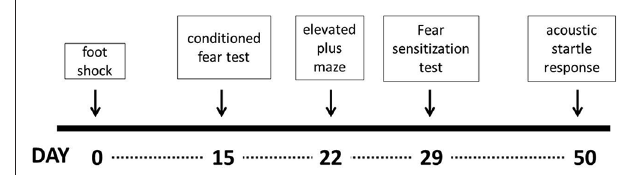
FIGURE 1 | Graphical representation of the time course of the experimental design